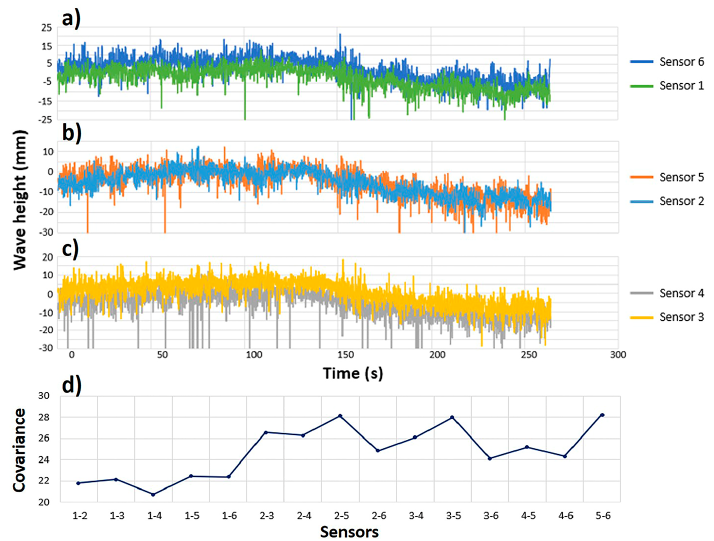
Figure 3. Variations of meniscus level and their covariances: ( a ) Sensors 1 and 6, ( b ) Sensors 2 and 5, ( c ) Sensors 3 and 4. ( d ) Covariances of bath level fluctuations.